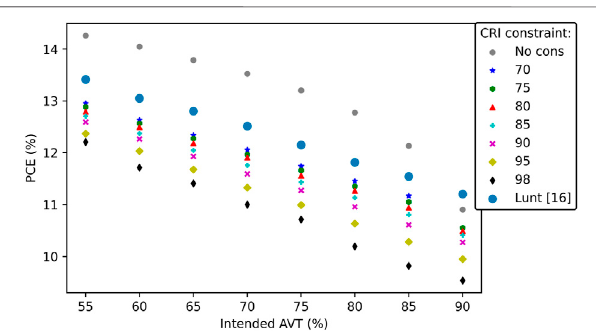
FIGURE 5 | AVT and PCE for different CRI constraints, note that the values on the x-axis are the AVT values asfound by the optimisation algorithm and may differ slightly from the ray-trace algorithm results, see the Supplementary Material for details. Values from Lunt [16] are based on the practical limit values in Figure 3B in his